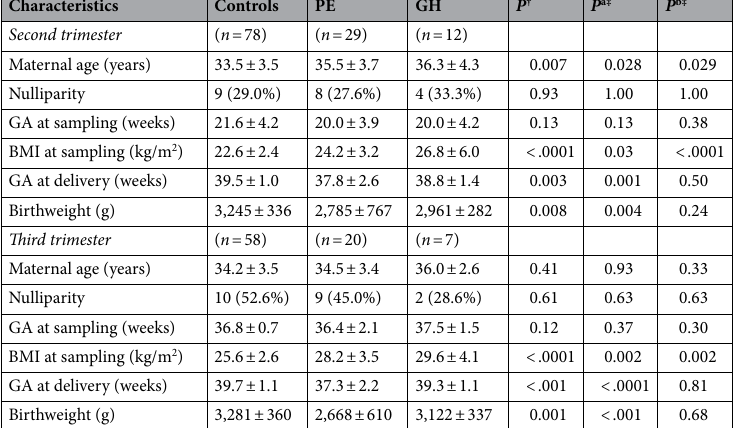
Table 1. Clinical characteristics of the study population. Data are given as mean ± SD or number (%). P a , PE versus controls; P b , GH versus controls. BMI body mass index, GA gestational age, GH gestational hypertension, PE preeclampsia. † P value by Pearson’s chi-square test, Fisher’s exact test or ANOVA as appropriate. ‡ Adjusted P value by Pearson’s chi-square test, Fisher’s exact test with step-up Bonferroni method or Dunnett multiple comparisons